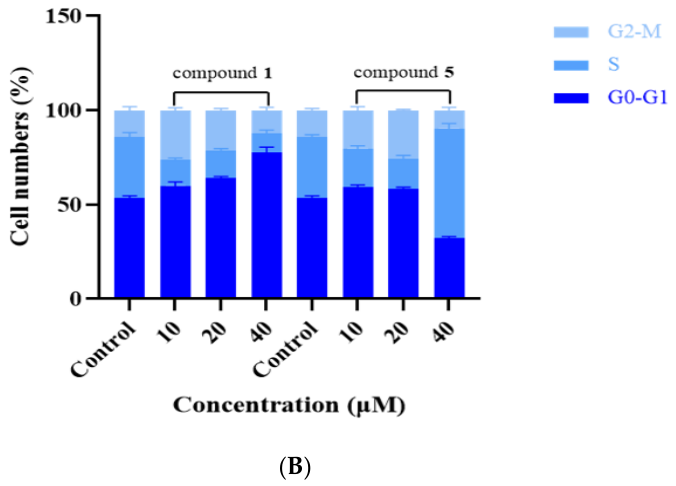
Figure 6. The effects of compounds 1 and 5 on the RKO cell cycle. ( A ) Cells were processed with 10, 20 and 40 μM for 48 h, respectively, collected, then stained with PI and analyzed by flow cytometry and the results were processed with Modfit LT 5.0; ( B ) statistics of RKO cell cycle results.